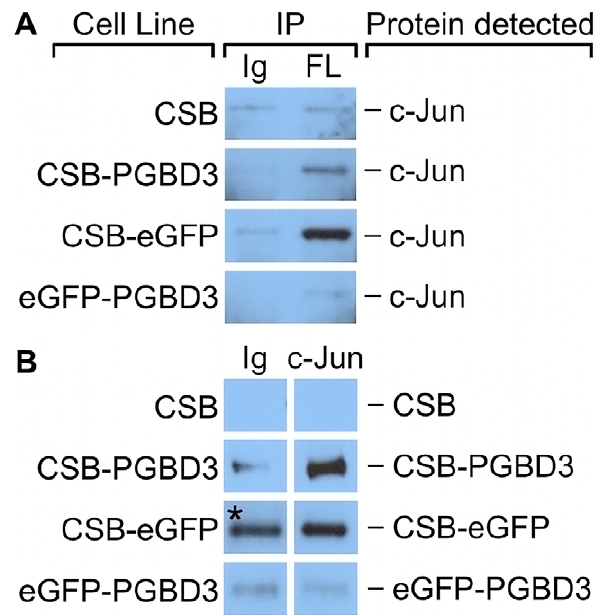
Figure 9. c-Jun co-immunoprecipitates with the CSB-PGBD3 and CSB-eGFP proteins, but not with eGFP-PGBD3. Nuclear lysates from UVSS1KO cells stably expressing FLAG-HA-tagged CSB, CSB-PGBD3, CSB-eGFP, and eGFP-PGBD3 were immunoprecipitated using anti-FLAG, anti-c-Jun, and a nonspecific antibody. (A) Western blots probed with anti-c-Jun antibodies. c-Jun is immunoprecipitates with anti-FLAG antibodies in cells expressing FLAG-HA-tagged CSB- PGBD3 or CSB-eGFP, but not full-length CSB or eGFP-PGBD3. (B) Western blots probed with anti-FLAG antibodies. FLAG-HA-tagged CSB- PGBD3 and CSB-eGFP immunoprecipitate with anti-c-Jun antibodies. * Denotes lane with uncharacteristically high background. The same nonspecific antibody was used for all negative control samples, which leads us to believe this band is an artefact due to contamination rather than a true IP of CSB-eGFP. IP, antibodies used for immunoprecipitation; Ig, anti-mouse IgG nonspecific antibody control; FL, mouse monoclonal anti-FLAG antibody; c-Jun, anti-c-Jun